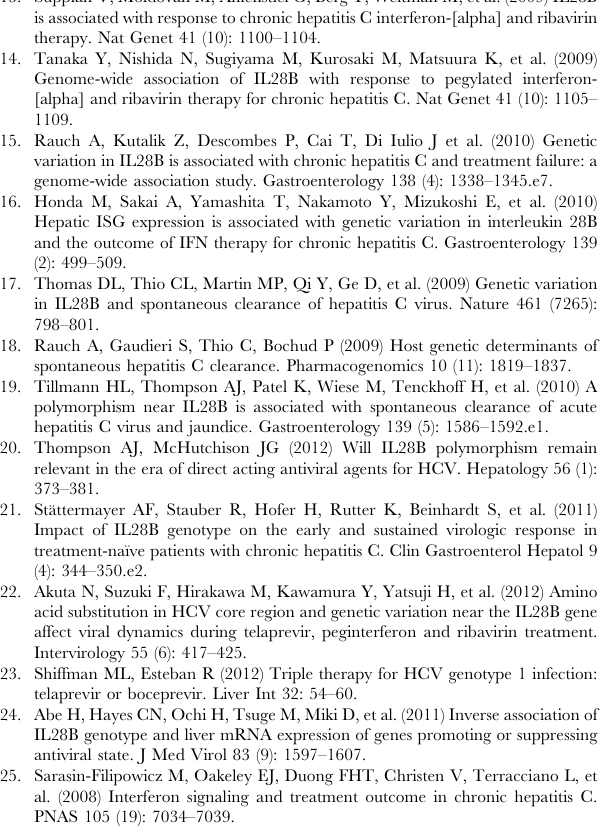
ALT (IU/mL), (C) GGT/ALT ratio, (D) pretreatment HCV RNA log 10 concentration (IU/mL). Horizontal bars represent the median. Mann-Whitney U-test was used to compare the baseline parameter. (TIF) Table S1 Comparison of the convenience of GGT/ALT ratio, HCV RNA and IFNL3 variants for response prediction in the evaluation and replication cohort.